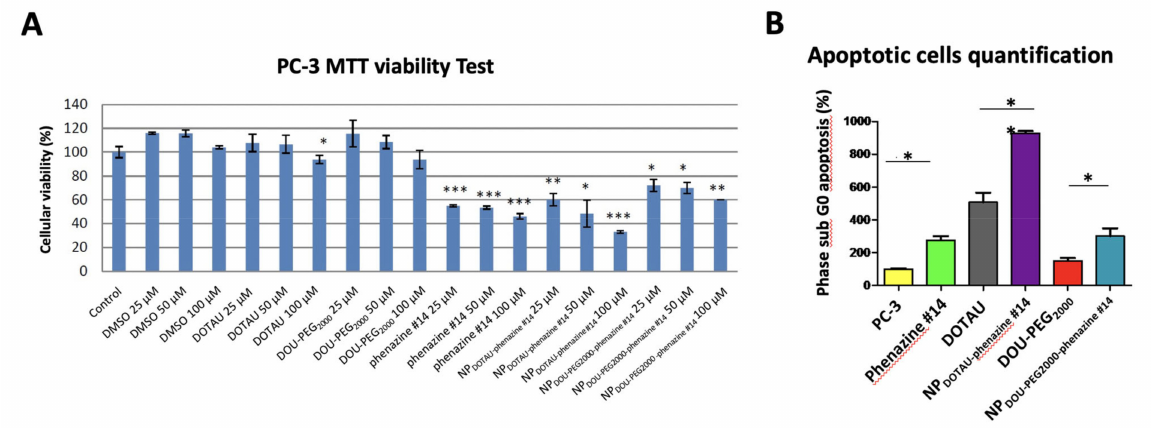
Figure 4. NP DOTAU-phenazine #14 inhibits cell viability and increases apoptosis of PC-3 cells in vitro. ( A ) MTT (3-(4,5- Dimethylthiazol-2-yl)-2,5-Diphenyltetrazolium Bromide) quantification of PC-3 cell viability was performed on cells treated with NP DOTAU-phenazine #14 and NP DOU-PEG2000-phenazine #14 at different concentrations (25, 50, 100), and NT (control) during 48 h. *, p ≤ 0.1, **, p ≤ 0.01 and ***, p ≤ 0.001. ( B ) Apoptotic cell quantification (SubG0 phase) by flow cytometry was performed on PC-3 cells treated with the compound NP DOTAU-phenazine #14 and NP DOU-PEG2000-phenazine #14 and NT (Non- Treated cells, control) at 100 µ M during 48 h and labeled with propidium iodide. The bar graph represents cell percentage in subG0 phase. *, p ≤ 0.1, **, p ≤ 0.01 and ***, p ≤